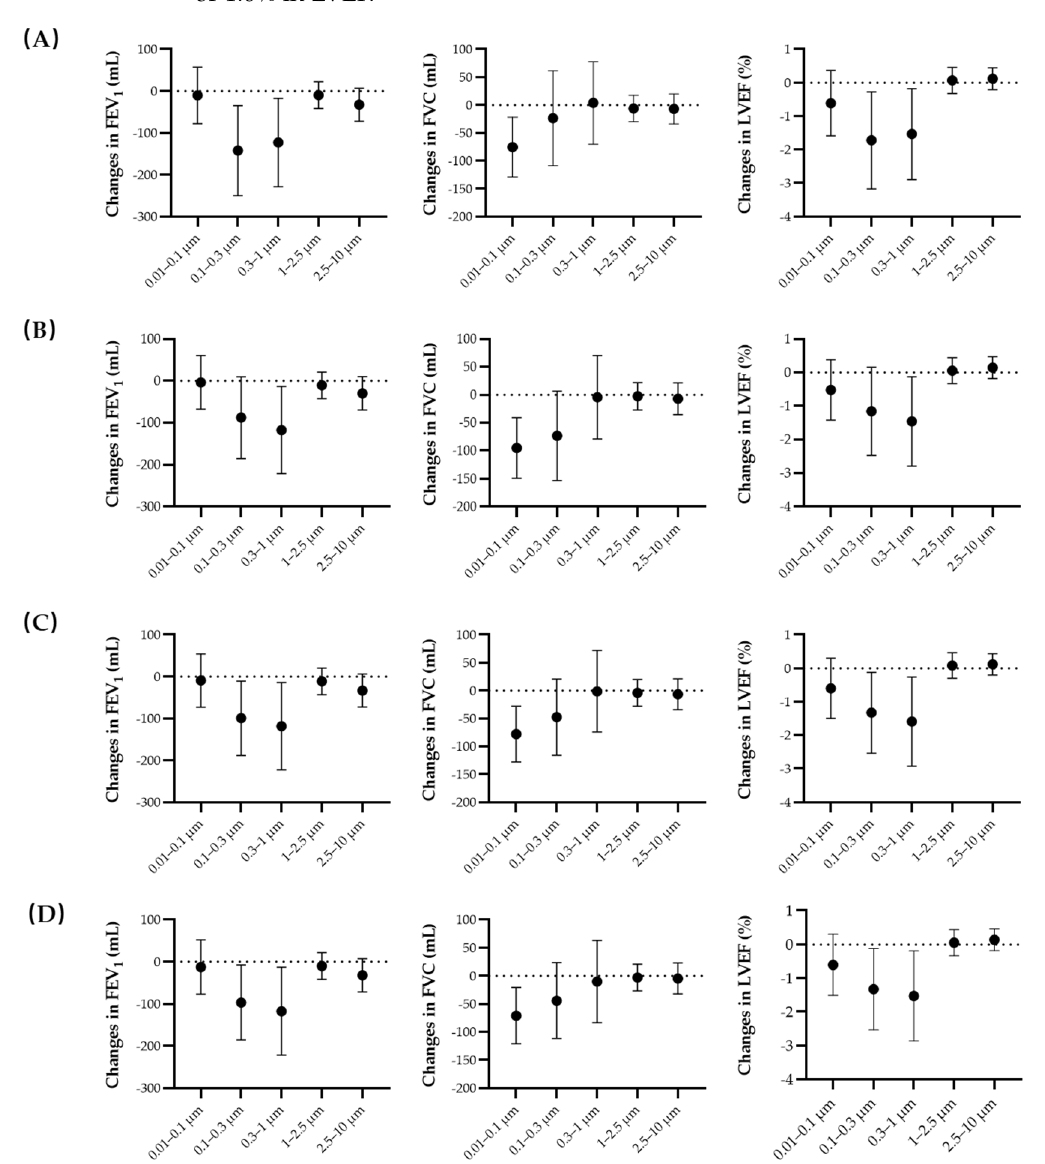
Figure 2. Changes (mean and 95% confidence intervals) in cardiopulmonary function measures associated with an interquartile range increase in size-fractioned PNC, adjusted for PM 2.5 and ( A ) NO 2 , ( B ) SO 2 , ( C ) O 3 , ( D ) CO. Abbreviations as in Tables 1 and 2.